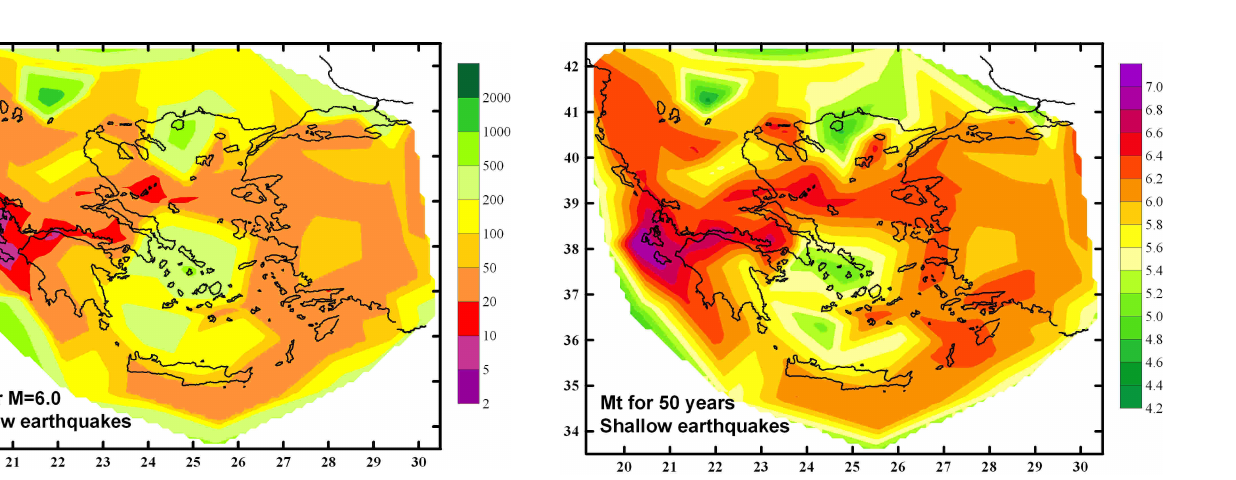
Figure 13. Spatial distribution of the most probable maximum mag- nitude, M t , of shallow earthquakes for a return period of 50 years within the broader Aegean